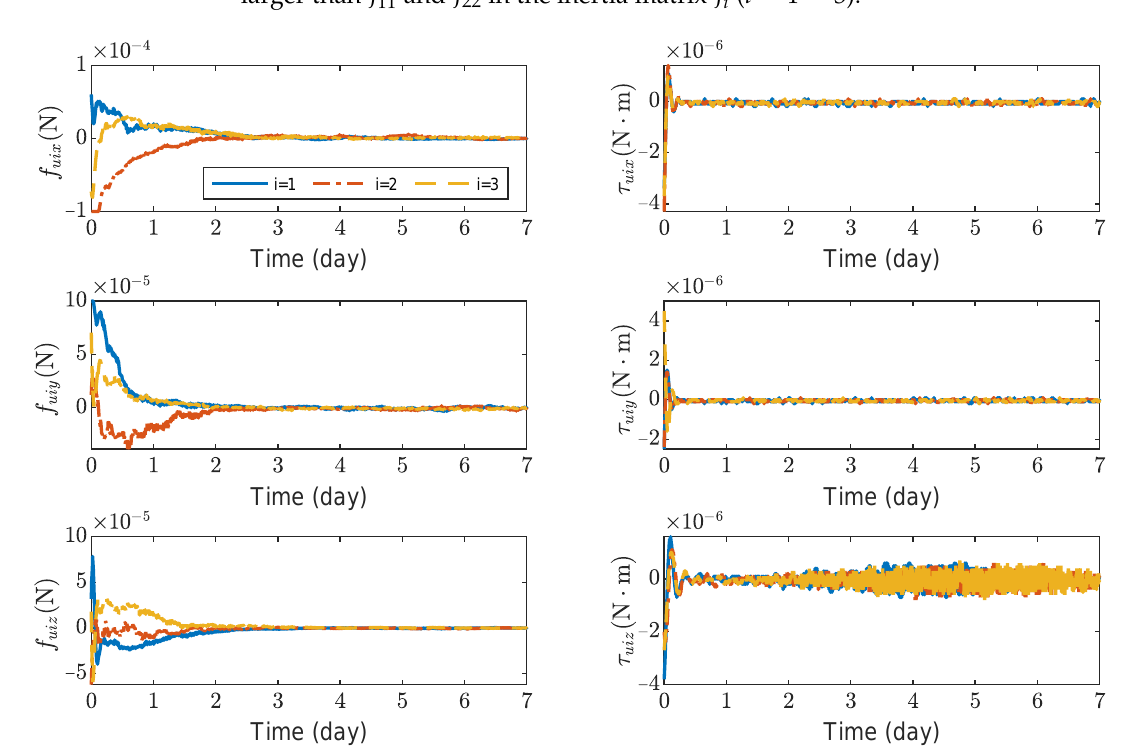
Figure 7. Control forces and control torques about SC1 ∼ 3, the max control force of spacecraft is 100 µ